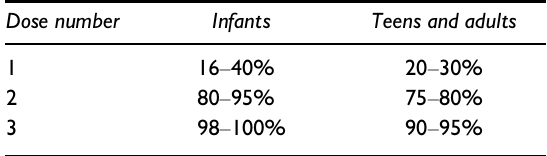
Table 1 Protection available after each dose of hepatitis B vaccine. Data from Margolis HS, Alter MJ, Hadler SC. Semin Liver Dis 1991;11:84 – 92